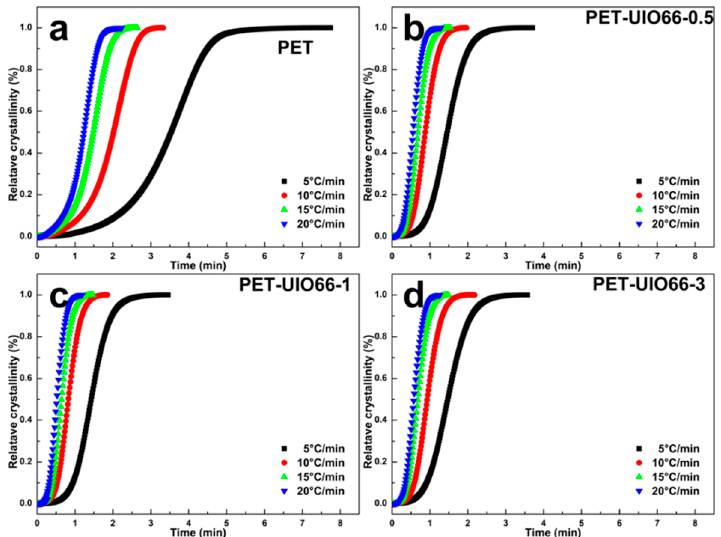
Figure 7. Relationship between time and relative crystallinity of the PET and the PET/UIO-66 nanocomposites at different cooling rates: ( a ) neat PET, ( b ) PET-UIO66-0.5; ( c ) PET-UIO66-1 and ( d ) PET-UIO66-3.